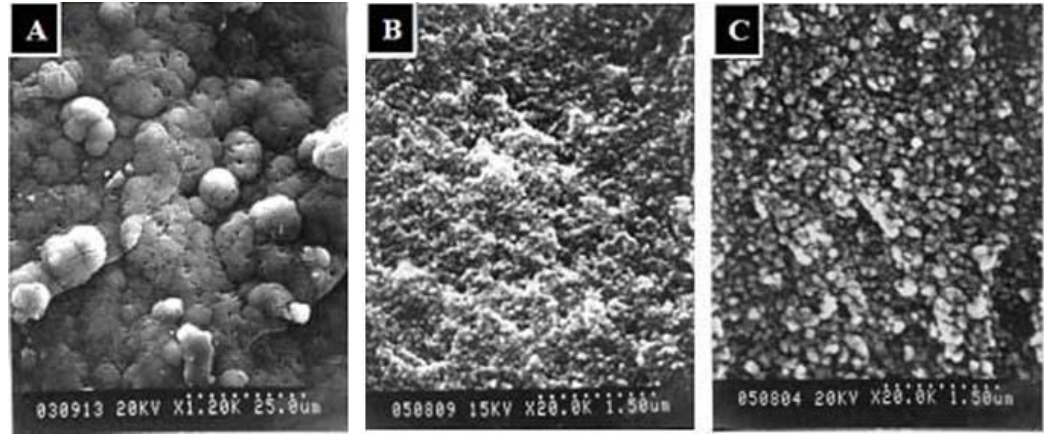
Figure 6. SEM investigation of mineralized templates. ( A ) mineral deposition on TPP-CG composites immersed in 1.5 × SBF for 21 days after pretreated with Ca(OH) grown in TPP-CG composites immersed in 1.5 × SBF for 3 days after pretreated with Ca(OH) . ( C ) mineral grown in TPP-CG composites immersed in 1.5 × SBF for 21 days 2 after pretreated with Ca(OH) 2